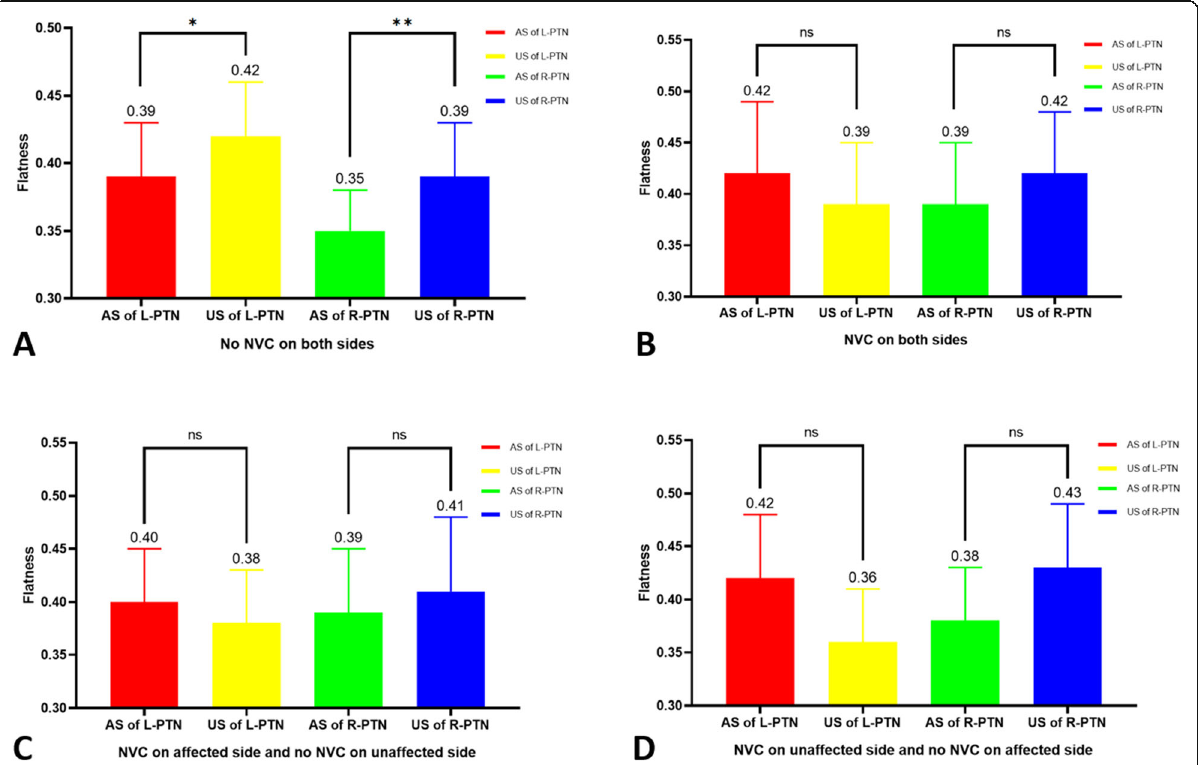
Fig. 4 Comparative analysis of Flatness with bilateral MCs under different NVC conditions. ( A ) No NVC on both sides. The MC of the affected side of the left PTN without bilateral NVC was lower than that of the unaffected side (0.39 ± 0.04 vs 0.42 ± 0.04, P < 0.051), the MC of the affected side of the right PTN without bilateral NVC was lower than that of the unaffected side (0.35 ± 0.03 vs 0.39 ± 0.04, P < 0.05). ( B ) NVC on both sides. There was no significant difference between groups. ( C ) NVC on affected side and no NVC on unaffected side. There was no significant difference between groups. ( D ) NVC on unaffected side and no NVC on affected side. There was no significant difference between groups.* P < 0.051; ** P < 0.05; ns: P > 0.05; NVC: neurovascular contact;L: Left; R: Right; AS: Affected side; US: Unaffected